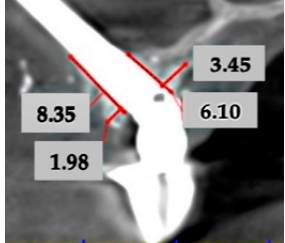
Figure 4. Bone gain measurement by CBCT at 6 months in two directions: through a perpendicular buccal and palatal lines to the implant axis (width) and through a parallel buccal and palatal lines to the implant axis at level of coronal part of the implant (length).